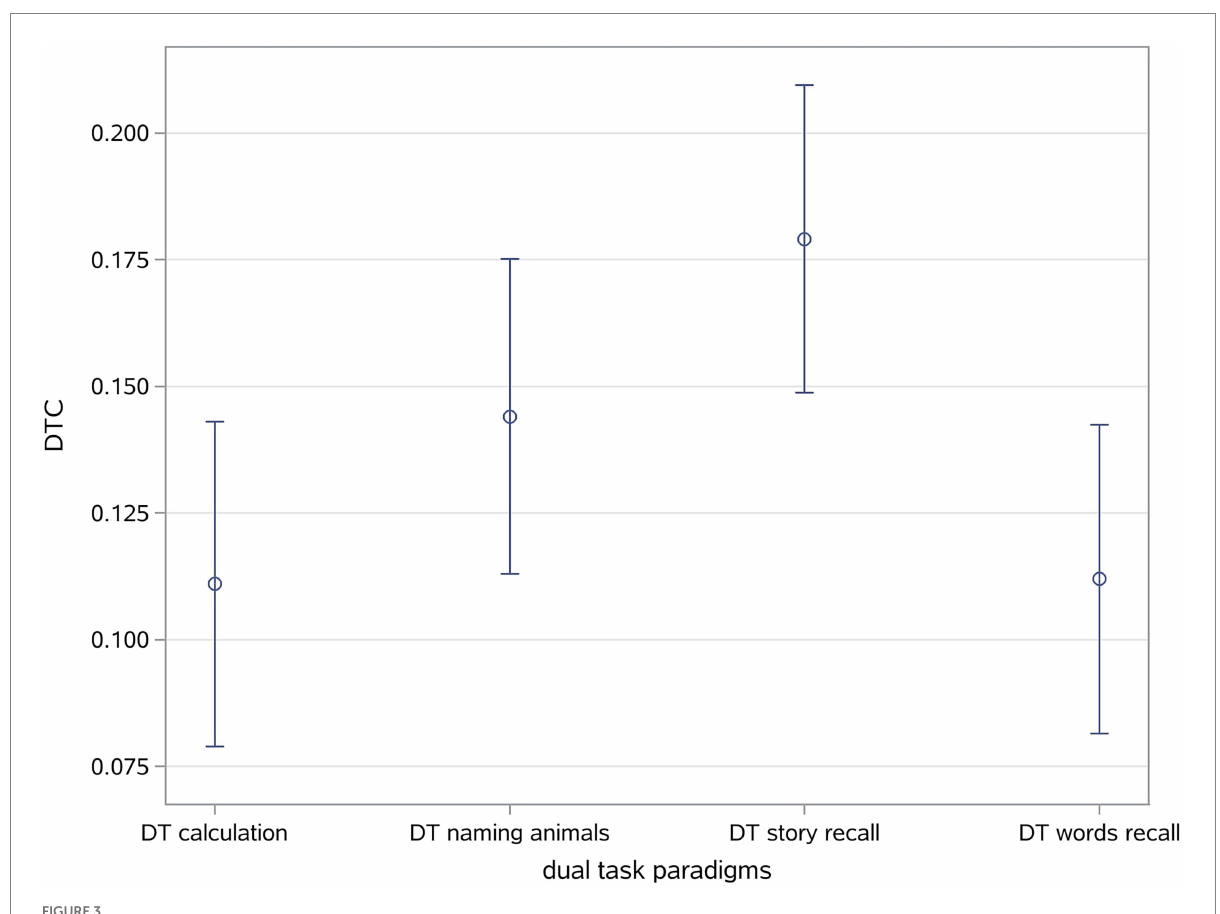
FIGURE 3 Mean difference in dual-task cost among various dual-task